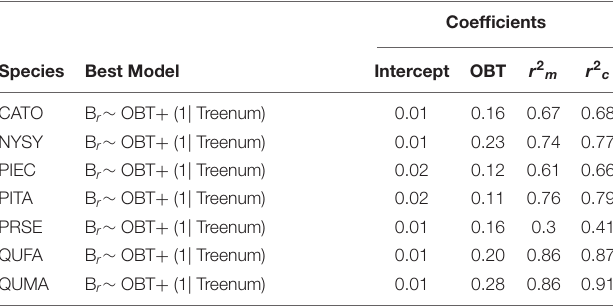
TABLE 5 | Bark rugosity (B r ) models for seven co-occurring species in the Tallahatchie Experimental Forest.